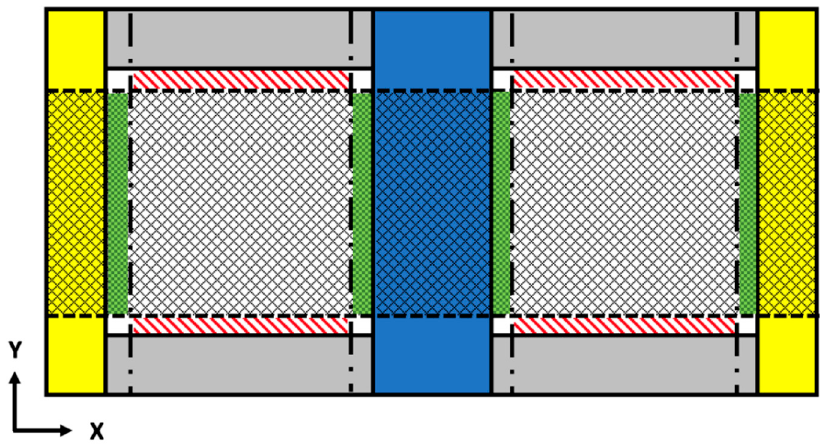
Figure 1. A Schematic (not to scale) of the 130.14 × 65.07 × 28.92 Å simulation system containing liquid confined within solid walls to be investigated. The yellow region indicates the hot copper wall (at temperature T h ) Λ h ; in blue is the cold copper wall Λ c (temperature T c ); in unhatched gray Λ a , are copper wall sections where the temperature is not controlled (copper walls of 10.845 Å, 21.69 Å, and 10.845 Å thicknesses.) The Λ h walls are at a higher temperature than Λ c , resulting in heat transfer in the direction indicated (perpendicular to the green interface δ ⊥ but parallel to the red interface δ || that lies along the Λ a ). The gray hatched regions identify the “bulk” fluid (region away from the interfaces). The white regions at the intersection of the copper walls indicate “double” interfaces.